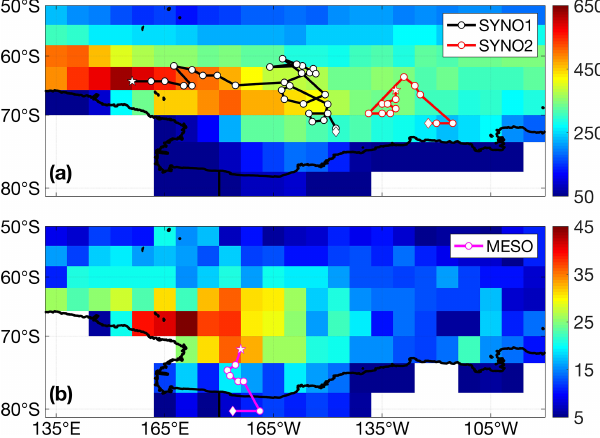
Figure 3. Accumulated track densities (the number of tracks per section) of (a) synoptic-scale cyclones and (b) mesoscale cyclones in the Ross Sea and surrounding regions over 1999–2014. The black, red and magenta lines indicate complete cyclone trajectories of selected cases (SYNO1, SYNO2, and MESO), and the circles represent the 6-hourly cyclone center locations, the pentacles in- dicate the starting positions and the diamonds present the ending